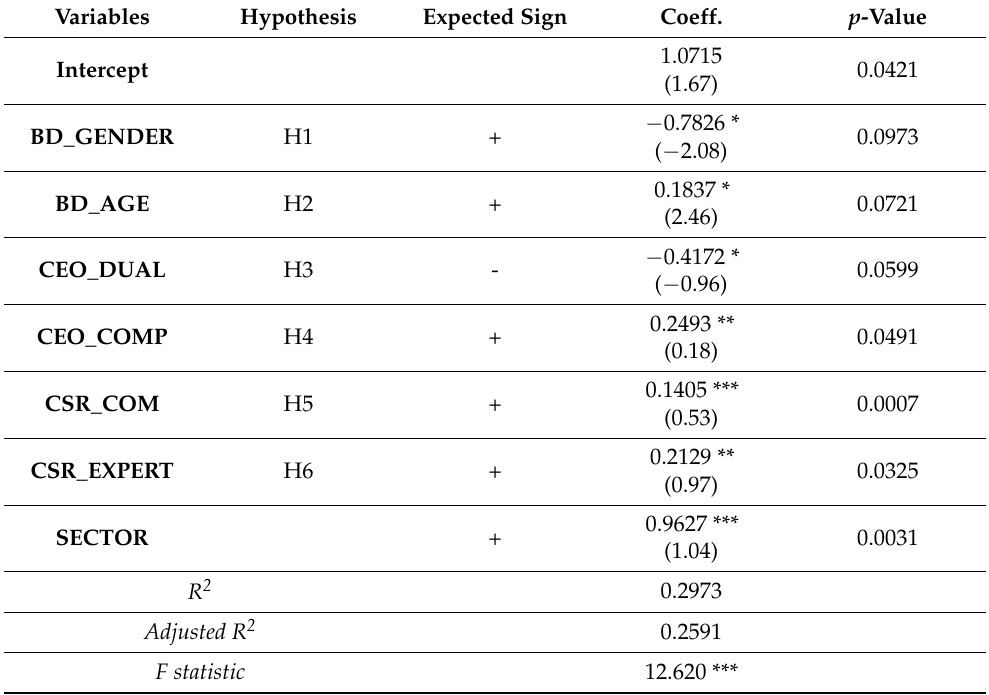
Table 8. Results of fixed effects regression analyses.